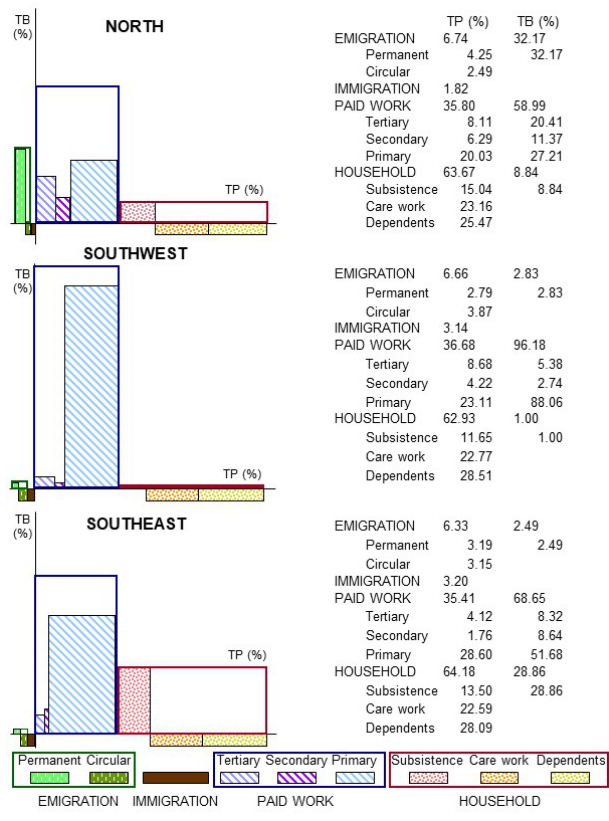
Fig. 7 . Relations between total benefits (TB) and total population (TP) for the commercial and subsistence land-based activities of each